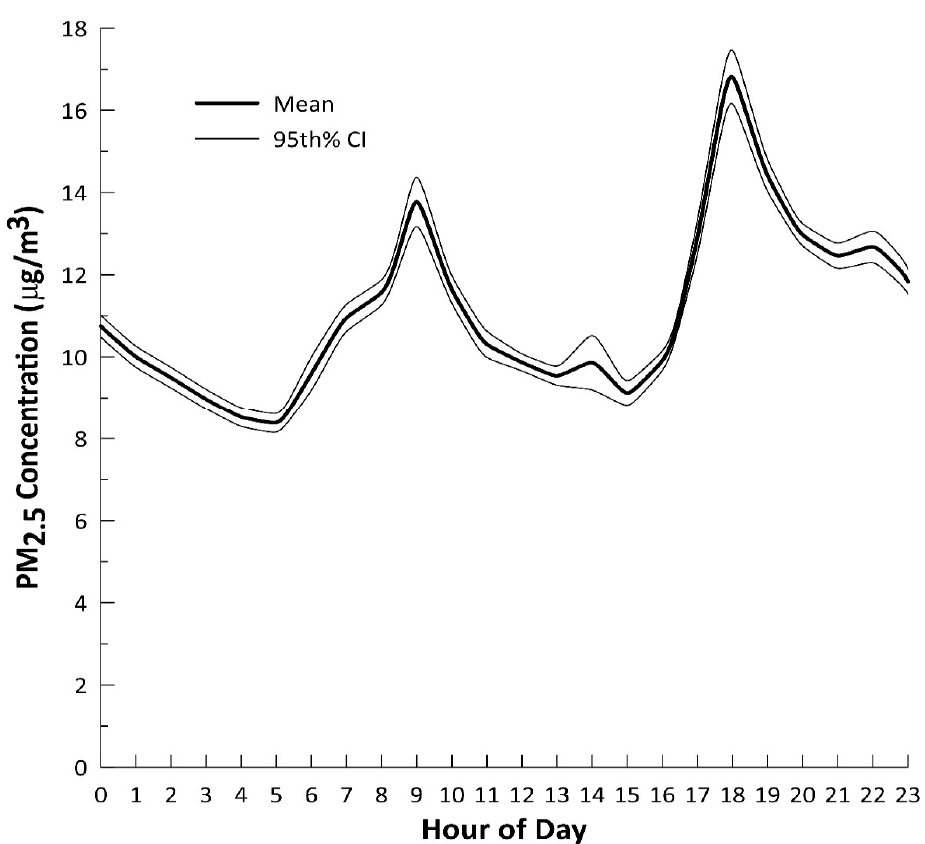
Figure 5. Hourly mean PM 2.5 concentrations during each hour of the day. The 95th percent confidence intervals illustrate the spread in the hourly PM 2.5 concentrations across each of the 240 participants with valid nephelometer data files.